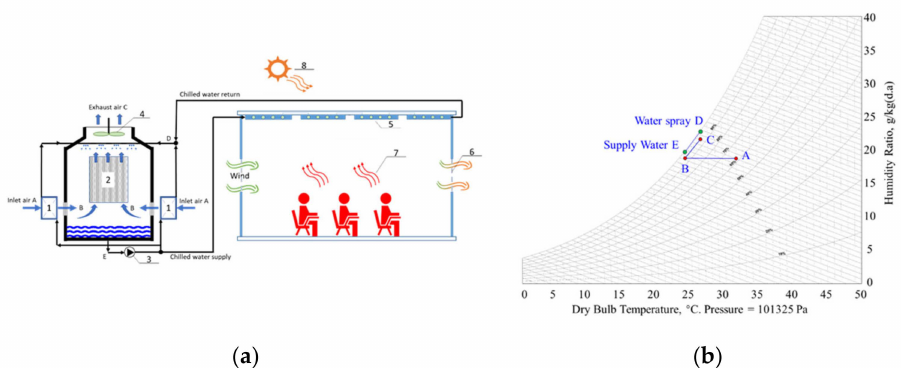
Figure 1. ( a ) Configuration of proposed hybrid cooling system: (1) air–water counterflow heat exchanger; (2) air–water counterflow padding tower; (3) water pump; (4) fan; (5) chilled ceiling; (6) window opening; (7) internal heat load; (8) solar flux. ( b ) Psychrometric process to